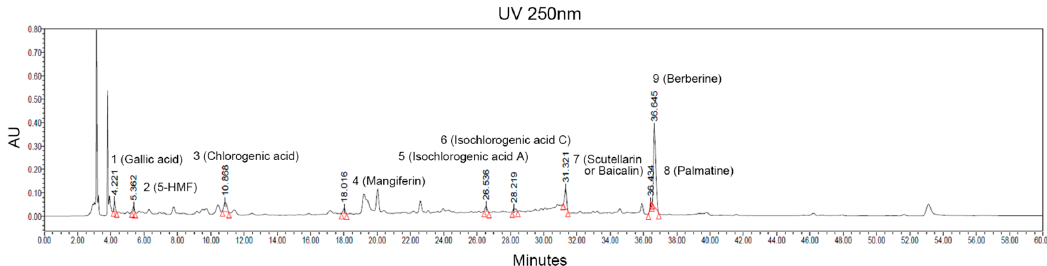
Figure 2. HPLC–UV λ = 250nm chromatograms of ACC extract produced from 14 di ff erent